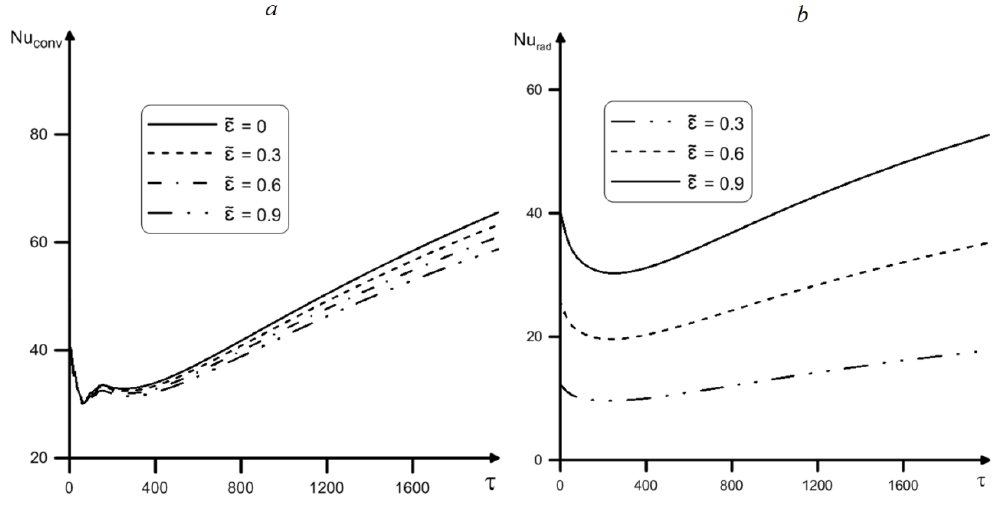
Figure 6. Dependences of the mean ( a ) convective and ( b ) radiative Nusselt numbers at the heat-generating source surface vs. surface emissivity and dimensionless time at Ra = 10 9 , Os = 1.